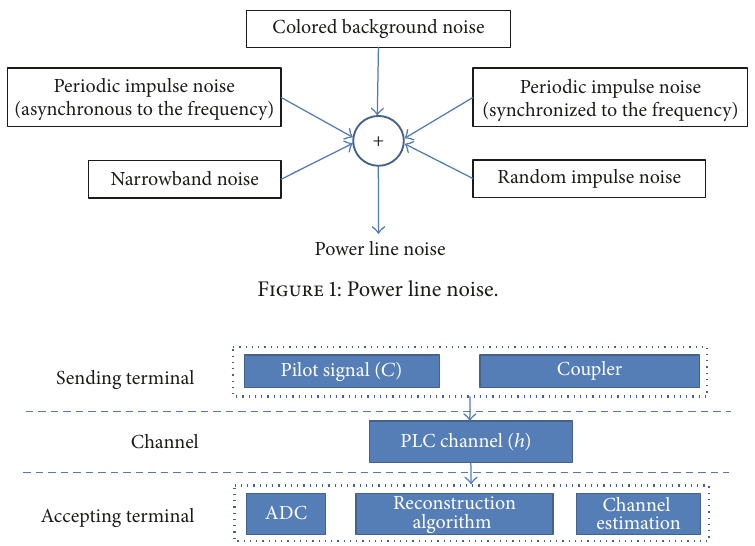
Figure 2: Block diagram of PLC estimation